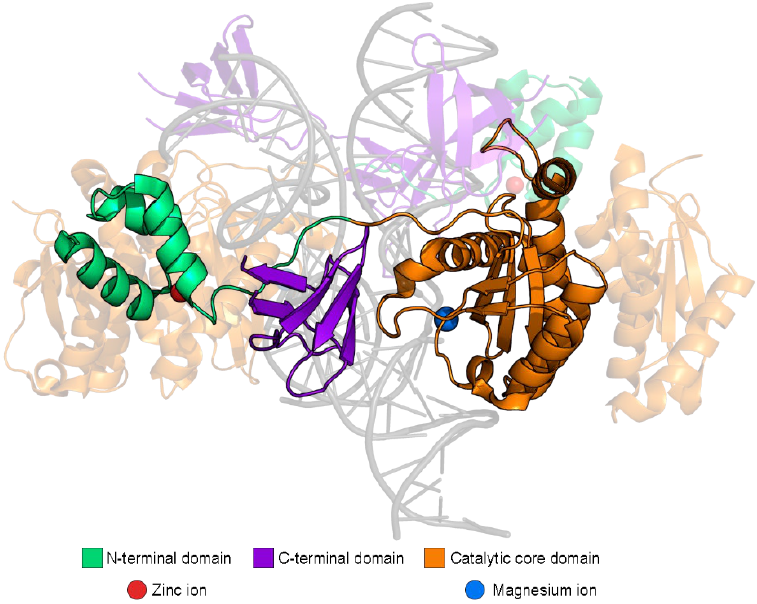
Figure 2. Structure of integrase domains within the HIV-1 intasome (PDB ID 5U1C). Despite IN being classically perceived as an enzyme that catalyzes HIV-1 genome integration, the pleiotropic effects of IN mutations on different stages of HIV-1 replication suggest that its functions go beyond the integration process.